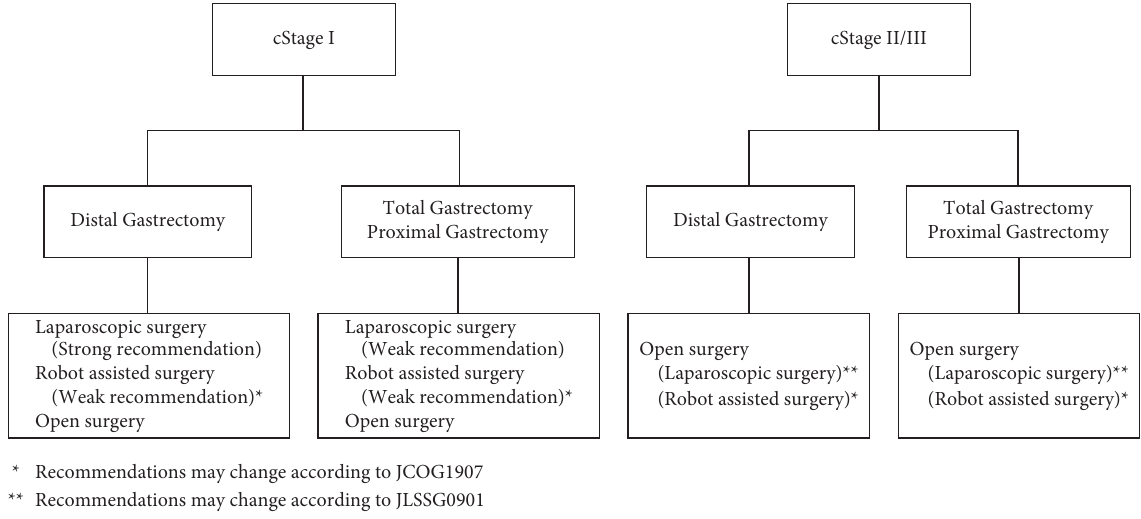
Figure 2: The selection of the current evidence-based surgical approach for gastrectomy for gastric cancer. Table 1: Multicenter prospective trials for minimal-invasive gastric cancer